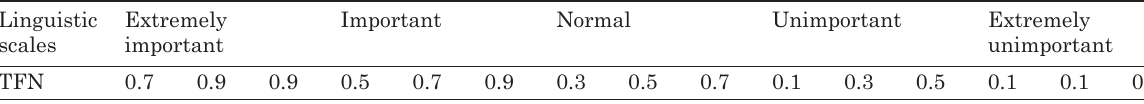
Fig. 1. Estimation procedure of fuzzy Delphi and DEMATEL Table 3. Scales for measurement